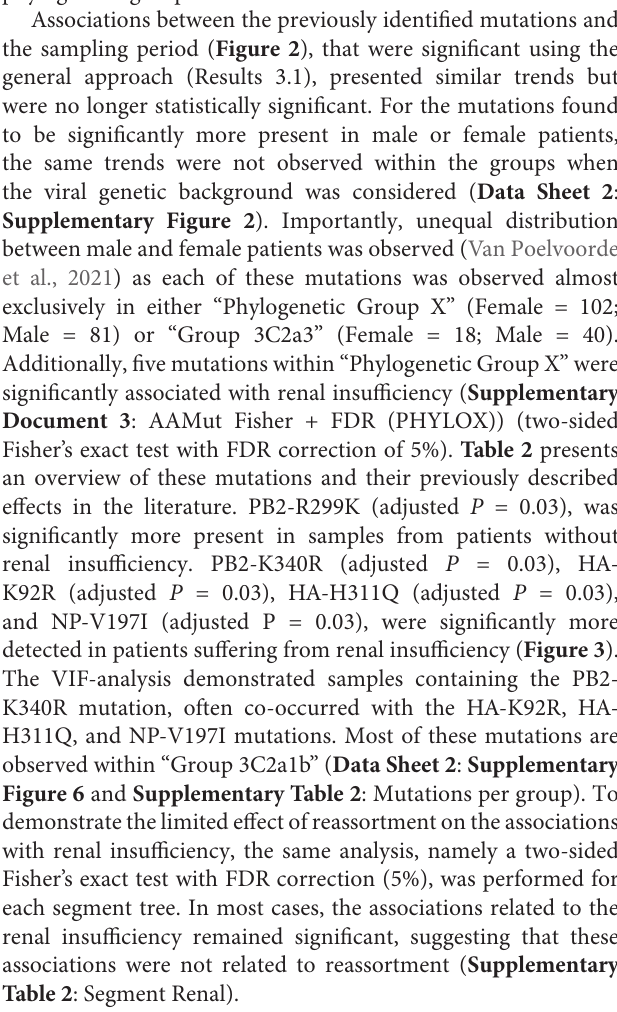
Figure 6 and Supplementary Table 2 : Mutations per group).